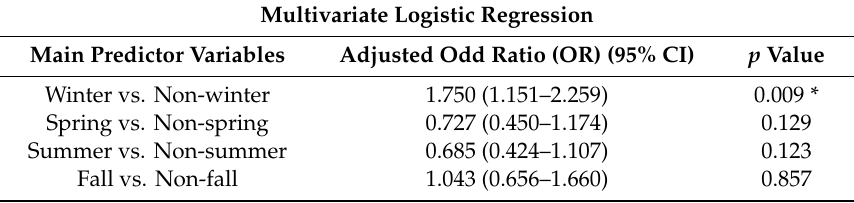
Logistic regression model on the association of the season (winter / non-winter, spring / non-spring, summer / non-summer, and fall / non-fall, respectively) with the age group (the young / the older) after adjustment for the clinical characteristic factors which reached statistical di ff erence between two age